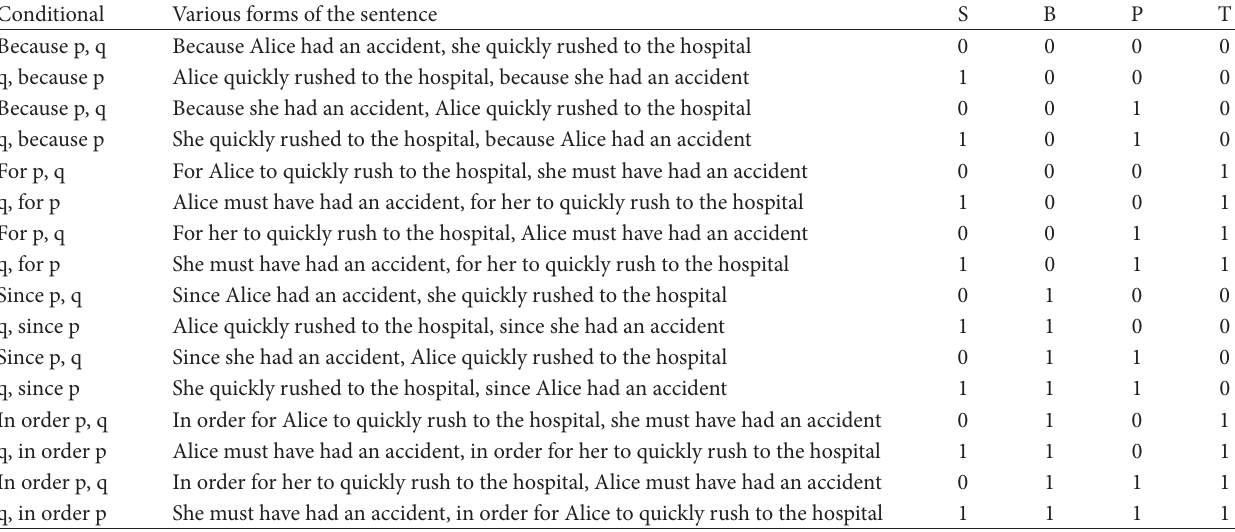
Table 7: Summary of conditional transforms. One statement is encoded in 16 different ways.